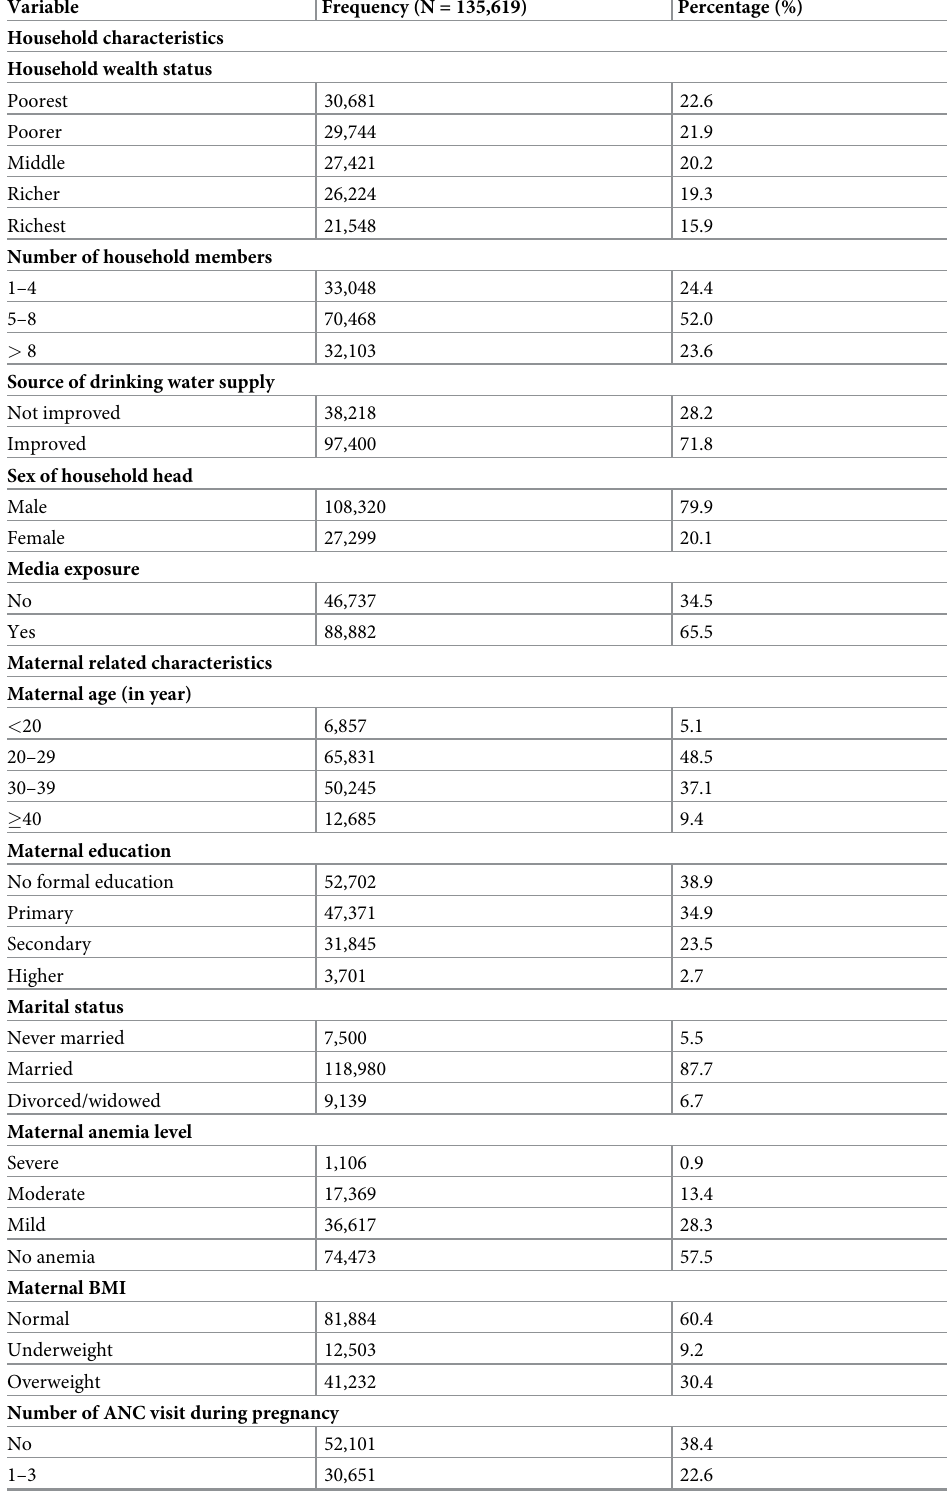
Table 2. Descriptive characteristics of children aged 6–59 months in sub-Saharan